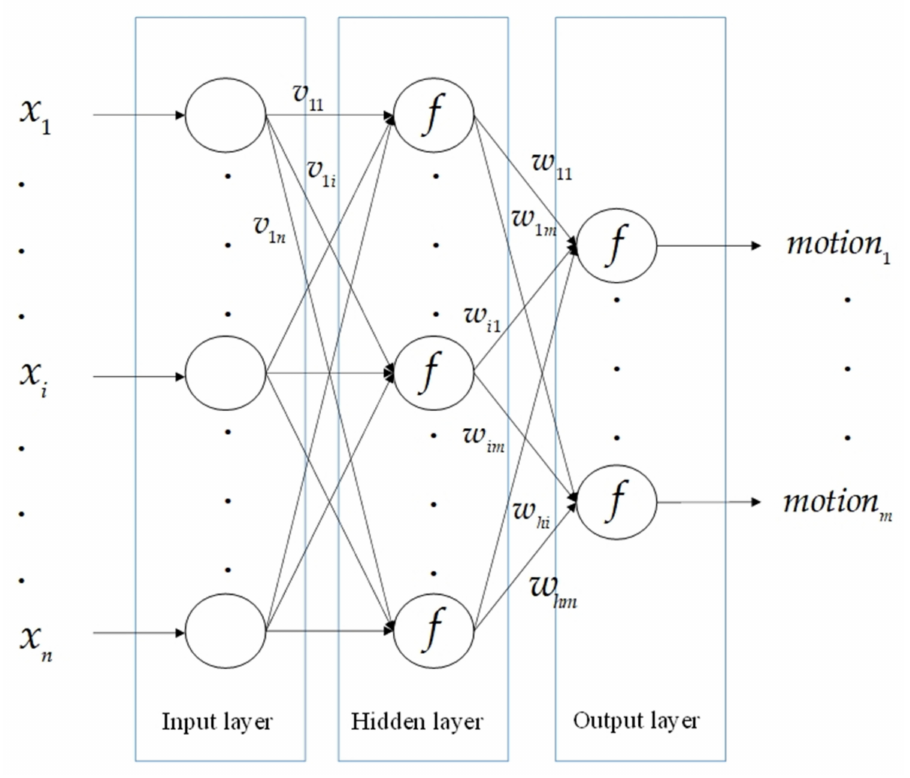
Figure 4. The basic architecture diagram of